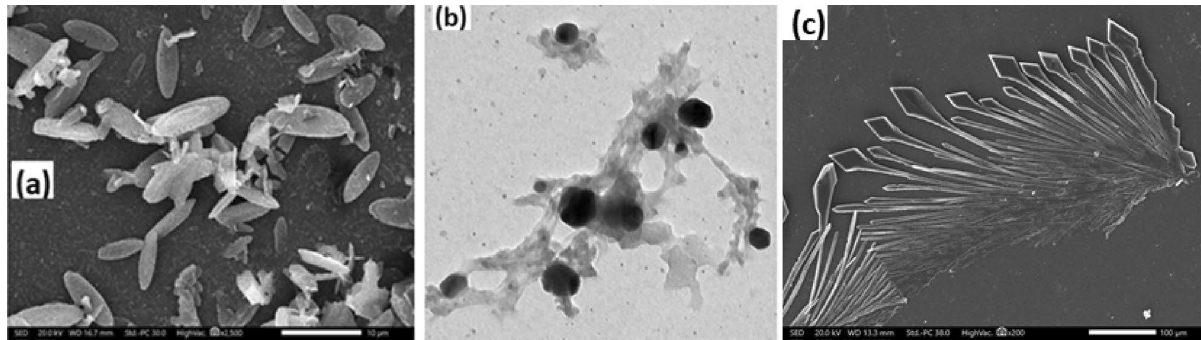
Figure 3. ( a ) SEM and ( b ) TEM images of the prepared Poly (5-nitro-orthanilic acid) 2 initiated by aniline. Figure 1(c) SEM image of uncatalyzed polymerization